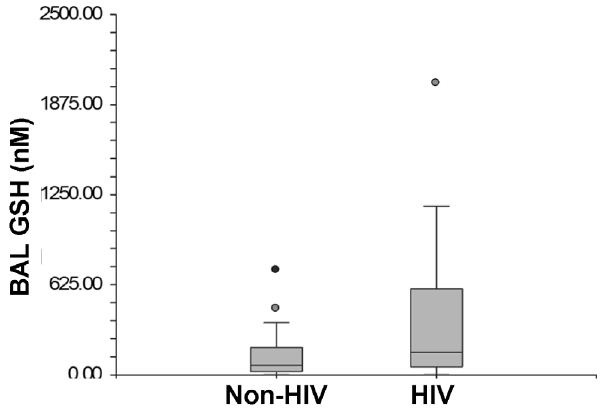
Figure 3. Box Plots of Glutathione Levels in Bronchoalveolar Lavage HIV-infected Subjects on and off Anti-retroviral Therapy.